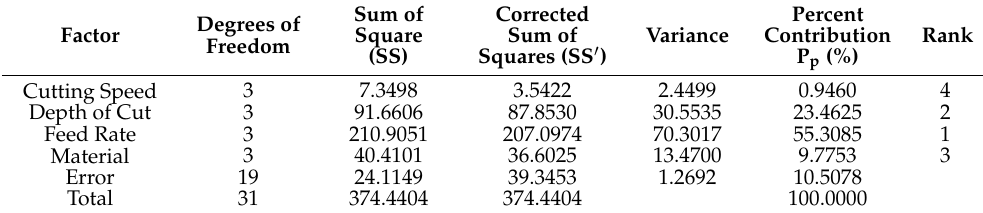
Table 2. Analysis of variance (ANOVA) for the surface roughness